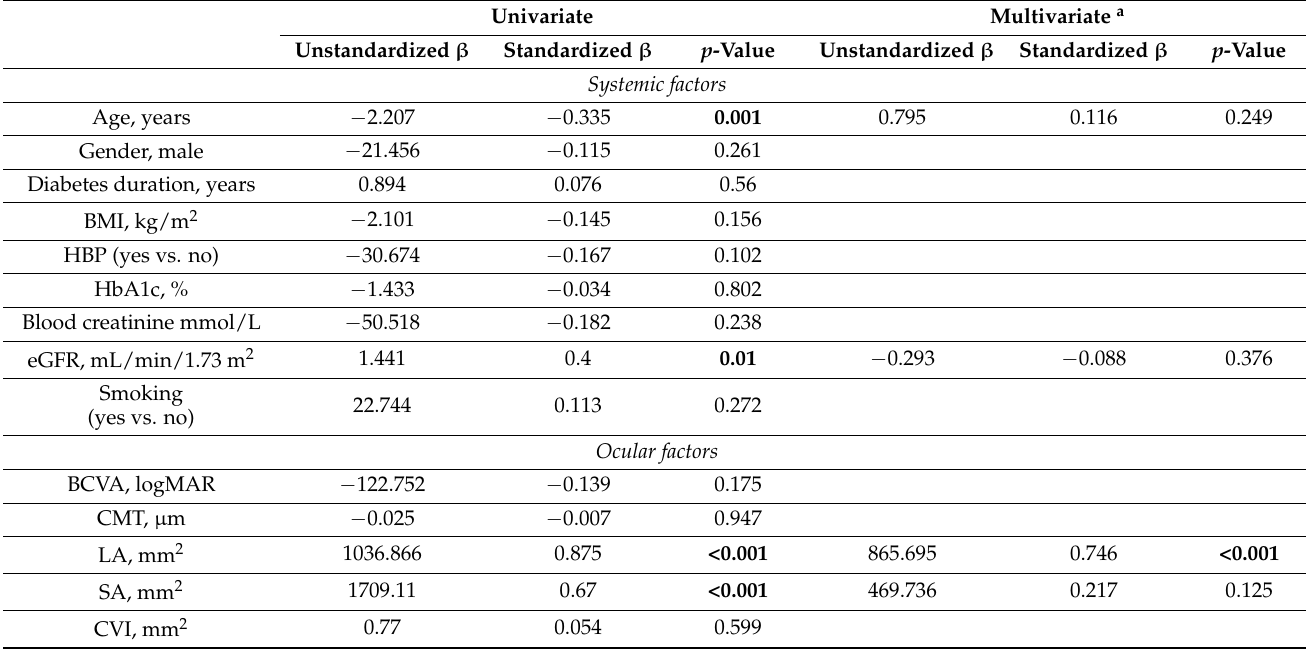
Table 6. Linear regression analyses of systemic and ocular factors associated with FChT.